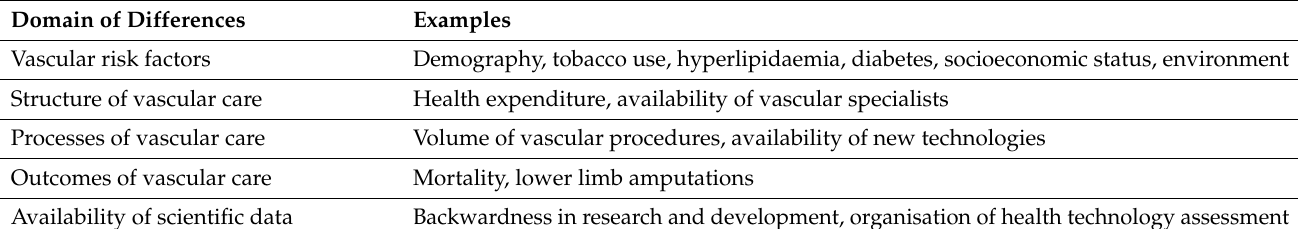
Table 1. Domains of disparities in peripheral vascular care between Western European countries versus Central and Eastern European